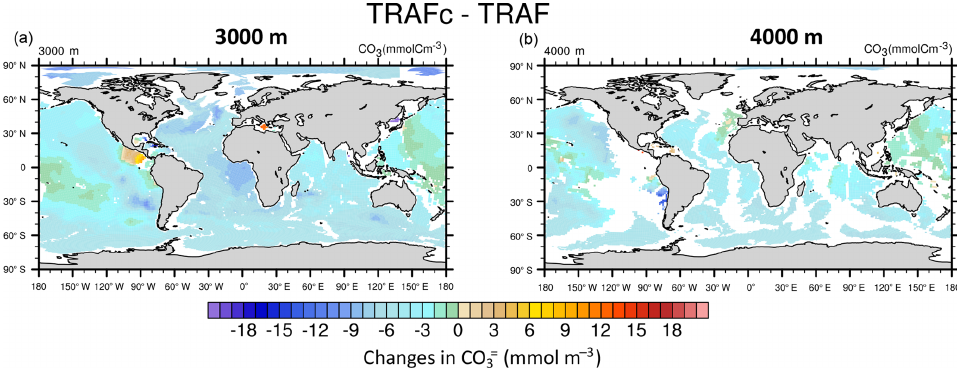
Figure 8. Differences in carbonate ion concentration (mmolm − 3 ), between TRAFc and TRAF simulations in 1850CE at the depth of 3km (a) and 4km (b)